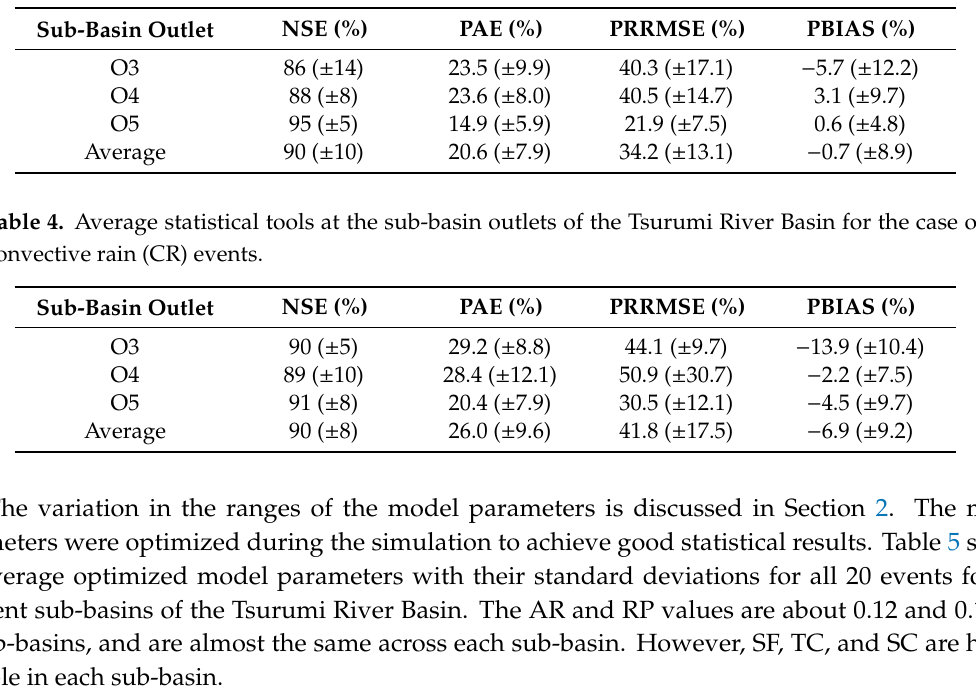
Table 3. Average statistical tools at the sub-basin outlets of the Tsurumi River Basin for the case of widespread rain (WR) events.